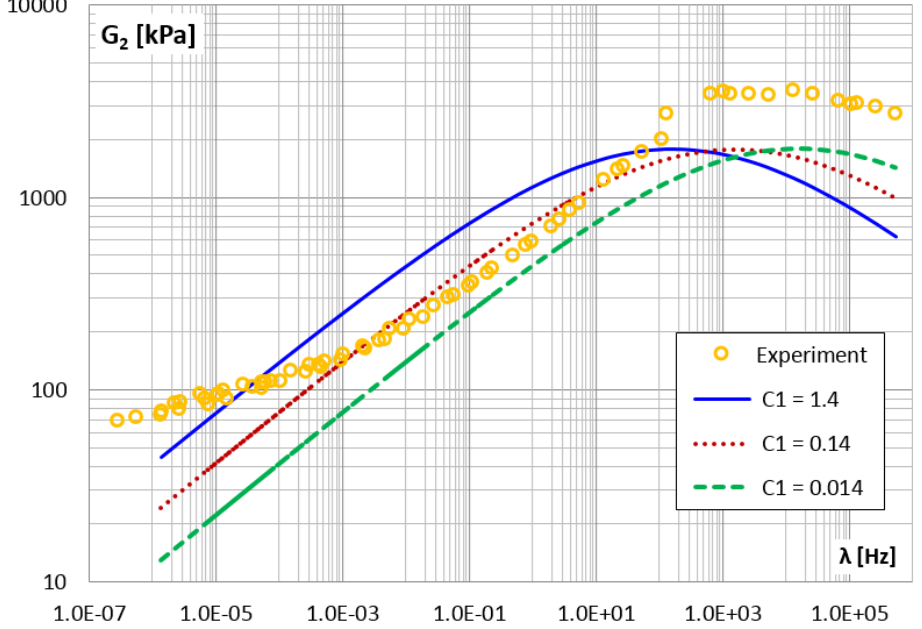
Figure 25. The shear loss modulus G 2 vs. frequency for different values of parameter c 1